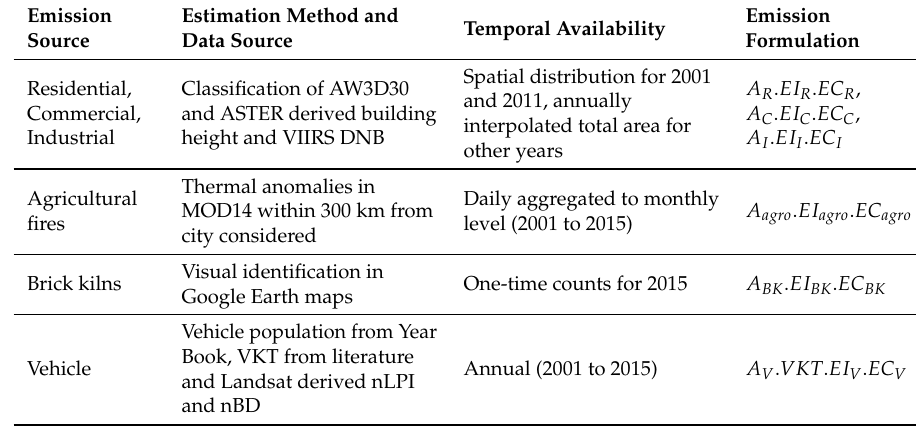
Table 1. Summary of emission sources considered. A refers to the total area in case of land-use sources ( LU ) or to the total vehicle population in case of vehicles, EI refers to emission intensity and EC refers to emission